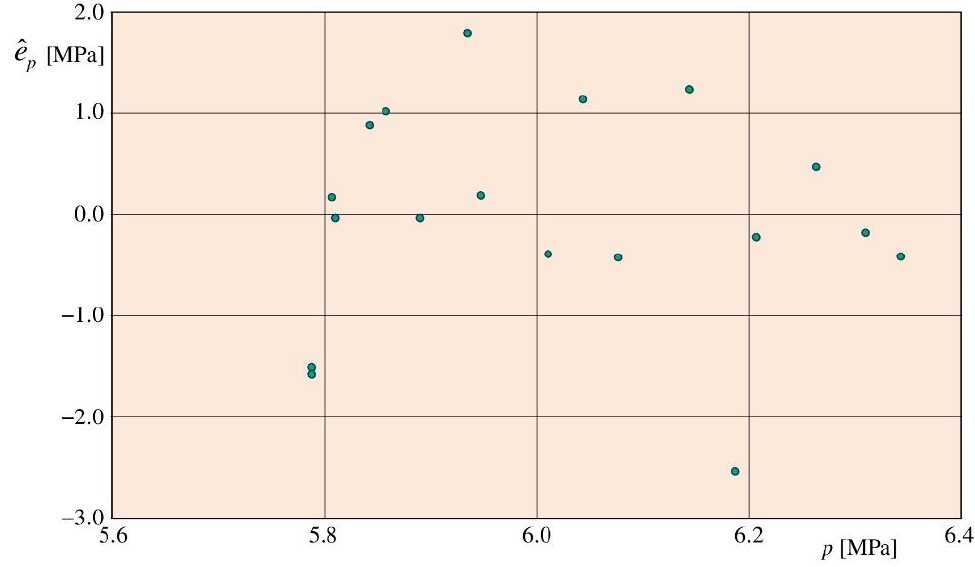
Figure 12. Graphical representation of the residuals for the pressure values against the actual obtained p values for the applied polynomial model of the third degree of dependence p = f ( t ).